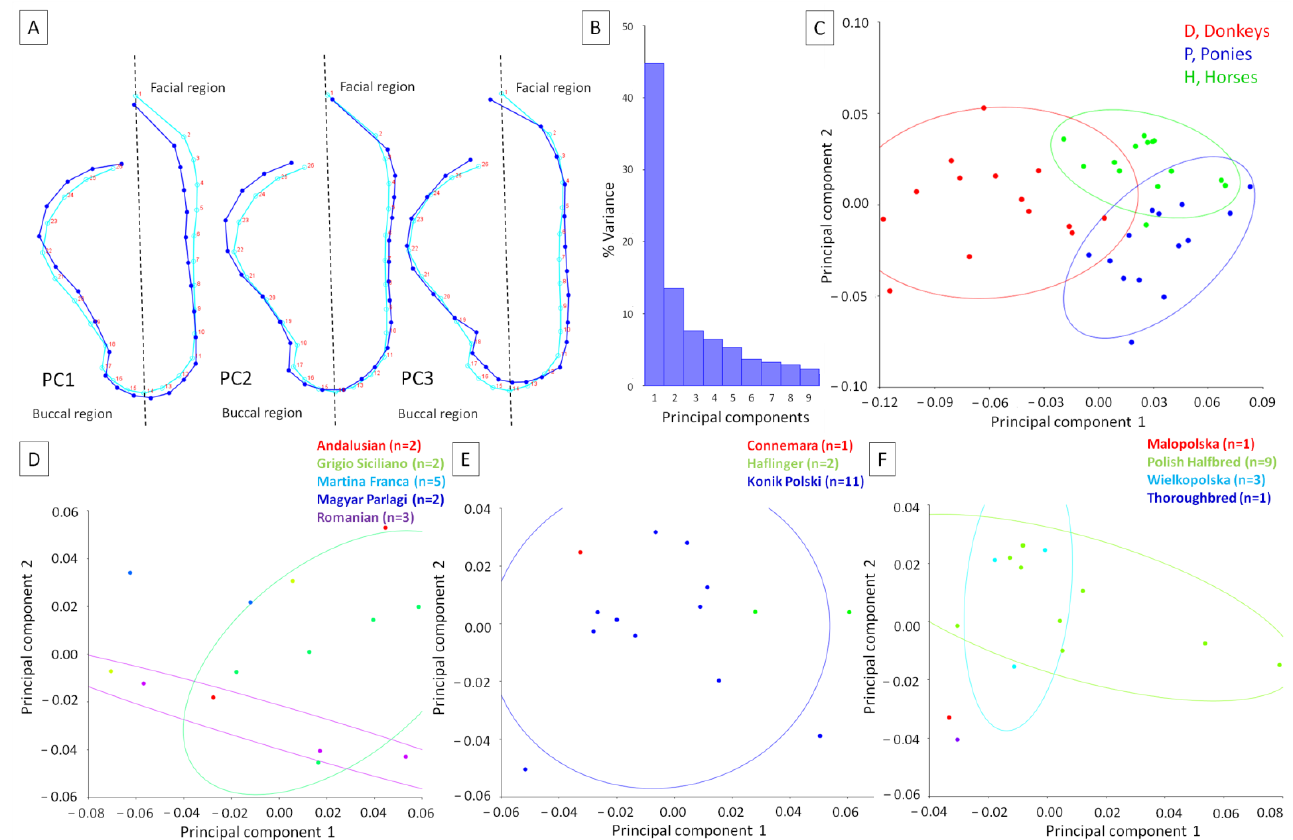
Figure 4. Principal component scores (PCs) of the head shapes of equids, as represented by ( A ) the wireframe graph, ( B ) histogram of variance, and ( C – F ) scatter plot of the PCs scores of the equids. On the wireframe graph ( A ), light blue landmarks and curves represent the consensus animal’s head shape. Dark blue landmarks and curves represent the extremum (minimum of the axis) values of PC1, PC2, and PC3, respectively. Dashed lines indicate the boundaries between regions. On the general scatter plot of the PCs scores ( C ), the color for each group was determined based on the classifier variables: D, donkeys; P, ponies; H, horses. On the detailed scatter plots of the PCs scores ( D – F ), the color of each breed with the number of individuals (n) is shown for donkeys ( D ), ponies ( E ), and horses ( F ). The confidence ellipses were drawn using a 0.9 probability and with a classifier as a criterion for grouping the observations.